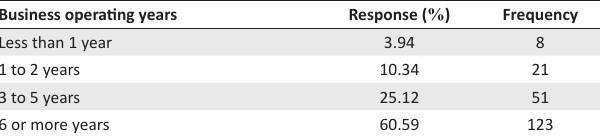
TABLE 6: Percentage response and frequency of years of business operation ( N = 203). Business operating years